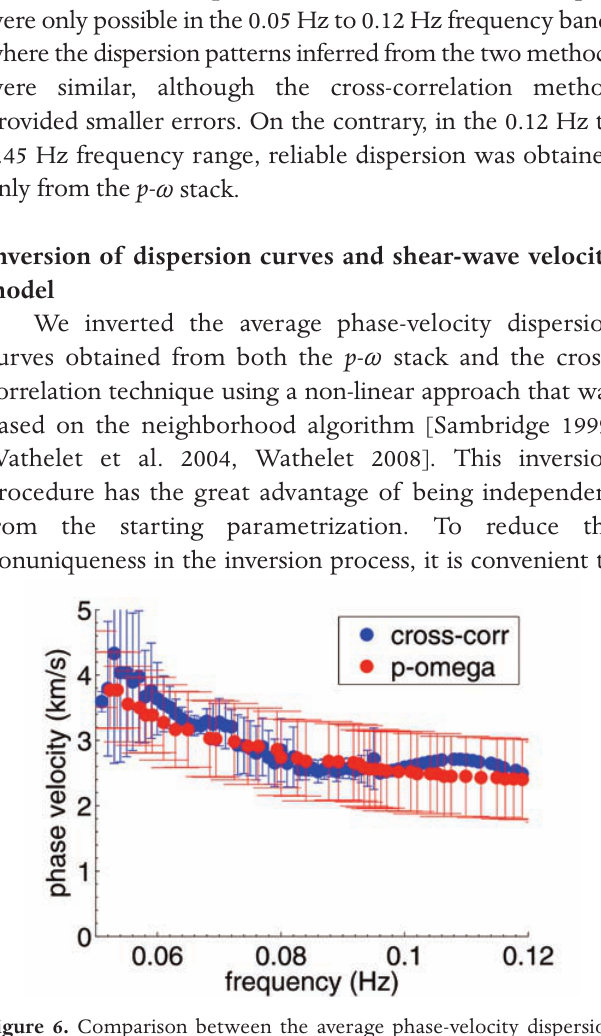
Figure 6. Comparison between the average phase-velocity dispersion curves obtained from the cross-correlation technique (cross-corr) and the p - ~ stack ( p -omega) in the 0.048-0.10 Hz frequency range. The error bars associated with the velocity values are standard deviations from the means of the earthquakes